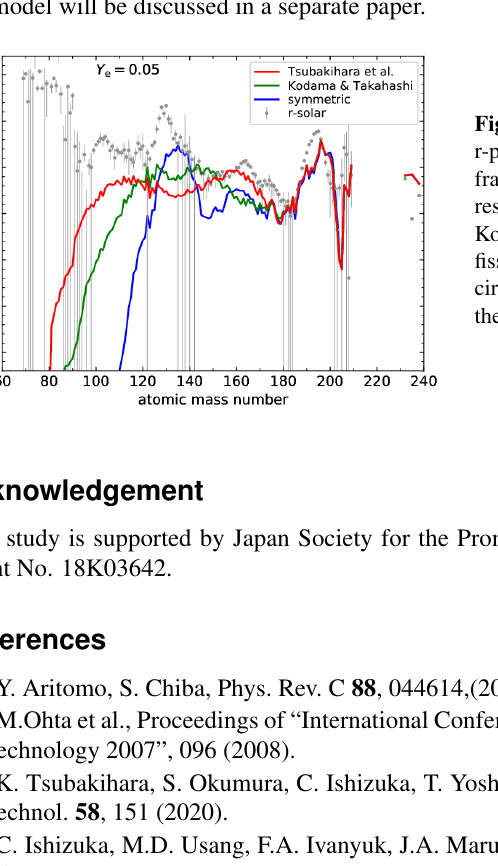
Figure 2. Mass and charge distribution of our semi-empirical yield model Y(Z, A) based on three dimensional Langevin model and recent evaluated yield models using abundant experimental data in actinides. The upper panel shows the mass distribution, while the lower color map displays the distributions of fission fragments on a nuclear chart. The center part of the color map is most abundant.